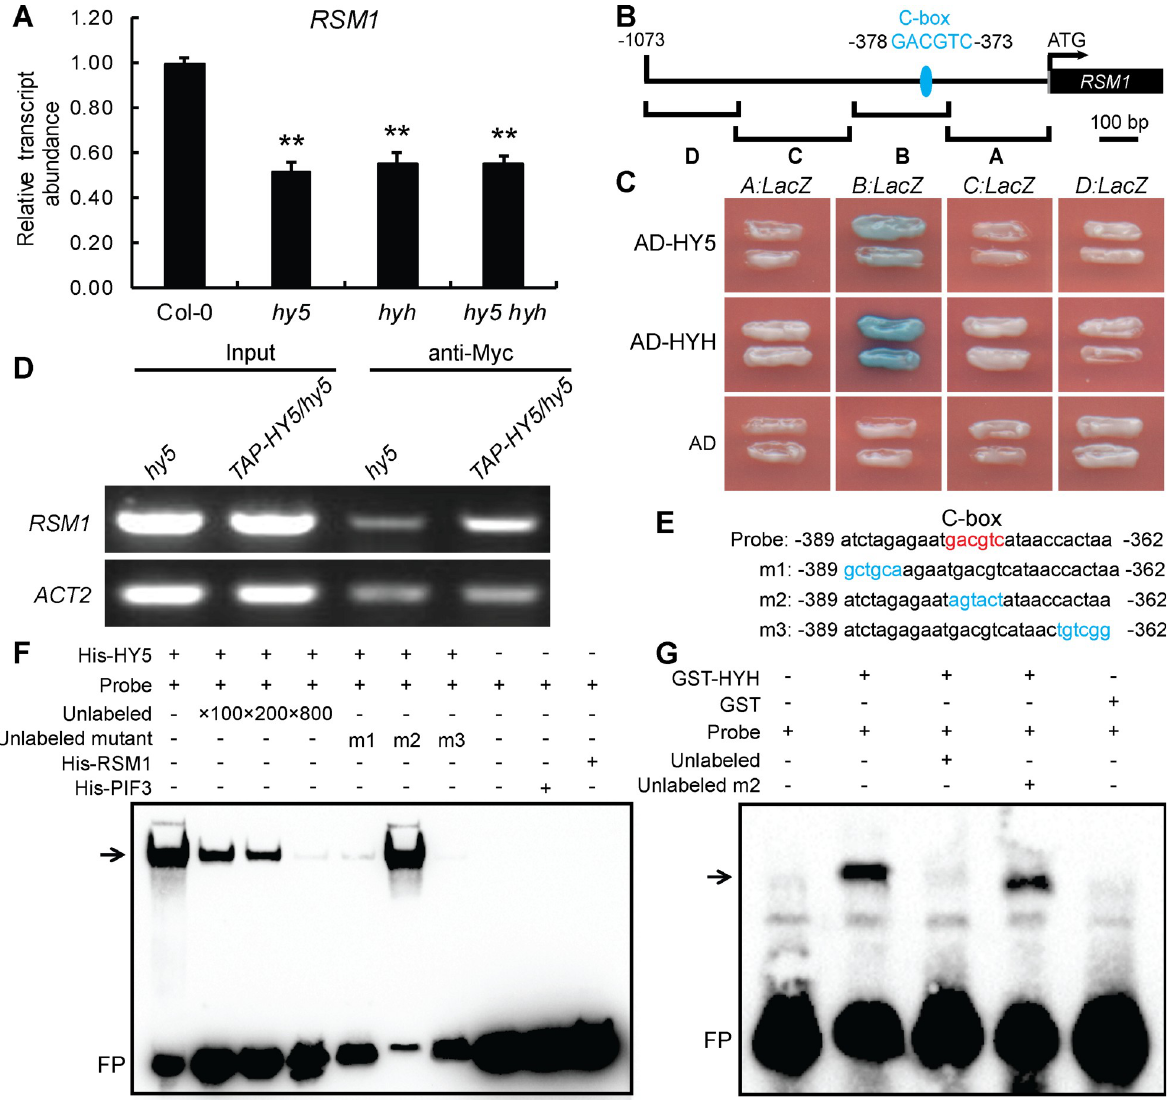
Fig 6. HY5 and HYH regulate RSM1 expression by binding to the RSM1 promoter. (A) Comparison of the expression levels of RSM1 in 7-day- old Col-0, hy5 , hyh and hy5 hyh seedlings. PP2A was used as a control for data normalization. The data are shown as the mean ± SD from three independent experimental replicates (n = 3). �� p < 0.01 indicates the significance of the differences as compared to Col-0. (B) Diagram of the RSM1 promoter fragments used to drive LacZ reporter gene expression in the yeast one-hybrid assay shown in (C). (C) Yeast-one hybrid assay showing that HY5 and HYH bind to fragment B of the RSM1 promoter. EGY48 cells were co-transformed with pB42AD-HY5/HYH and the pLacZ2U-RSM1 promoter. (D) ChIP-qPCR to assess HY5 binding to the RSM1 promoter in vivo . Twelve-day-old hy5 and 35S : TAP-HY5/hy5 seedlings were harvested for ChIP-qPCR assays using anti-Myc antibody to immunoprecipitate genomic DNA segments. The input was genomic DNA that was not subjected to immunoprecipitation. ACT2 was used as a negative control. (E) Diagram of the WT version of the C-box-contained biotin-labeled DNA probe and various biotin-unlabeled mutant versions of the RSM1 promoter subfragments used in the EMSAs shown in (F) and (G). The C- box element in the WT DNA probe is shown in red, whereas nucleotide substitutions in the mutated subfragments are shown in blue. (F) EMSAs of HY5 binding to the RSM1 promoter in vitro . The biotin-labeled DNA probe was incubated with His-HY5 protein. His-PIF3 and His-RSM1 were used as negative protein controls. (G) EMSAs of HYH binding to the RSM1 promoter in vitro . The biotin-labeled DNA probe was incubated with GST-HYH protein. GST was used as the negative protein control. In (F) and (G), the symbols “+” and “ − ” indicate the presence or absence, respectively, of the reagent that is indicated at the the top left of the panel. FP, free probe.